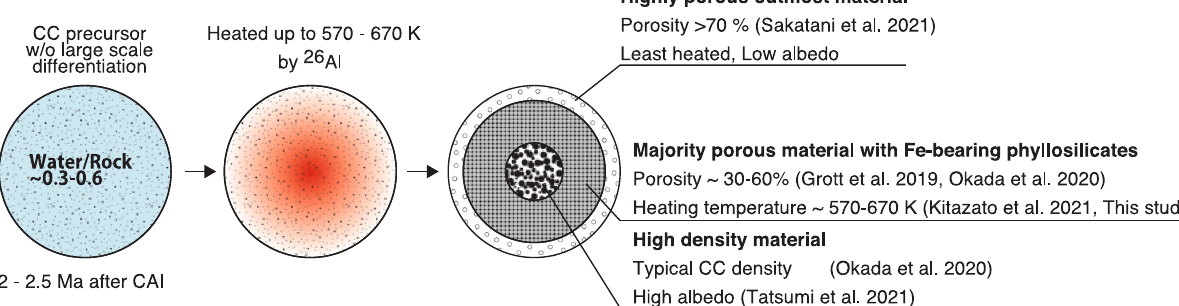
where R n indicates the re fl ectance for the band fi lter and coef fi cients are wavelength weights. Re fl ectance values were weighted by the wavelength. When the value is positive, there is absorption at the w band. The ambiguity of absolute 0.7- µm absorption measurement from the sensitivity calibration of ONC-T is 1.6% 12 .